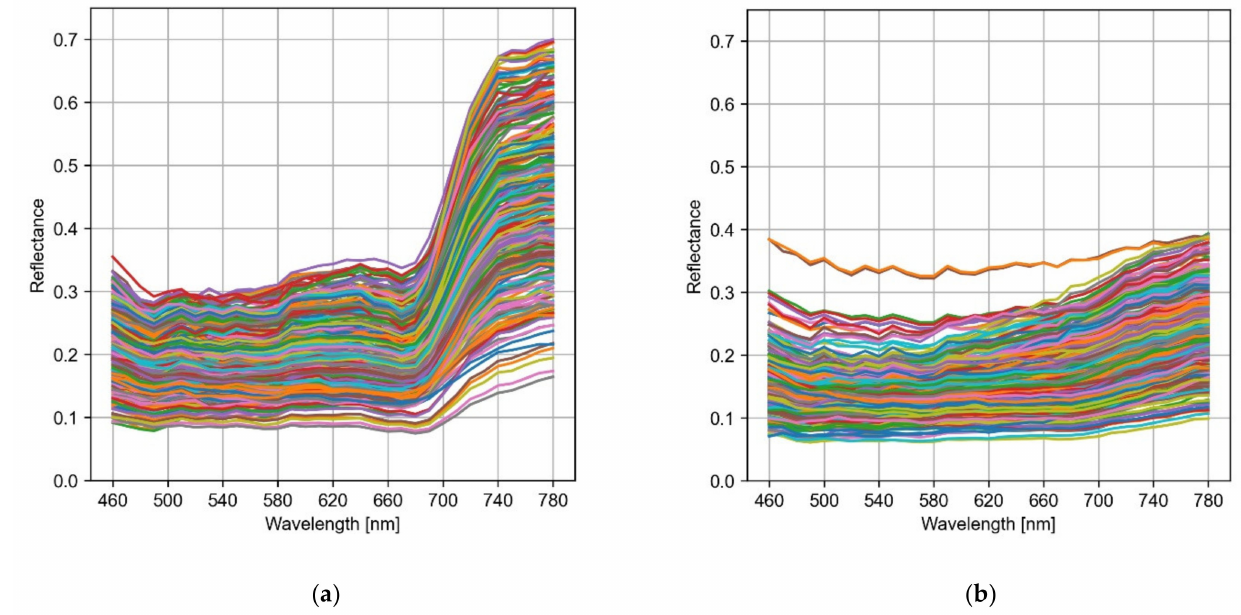
Figure 3. Superpixel-averaged reflectance spectra: ( a ) healthy area; ( b ) diseased